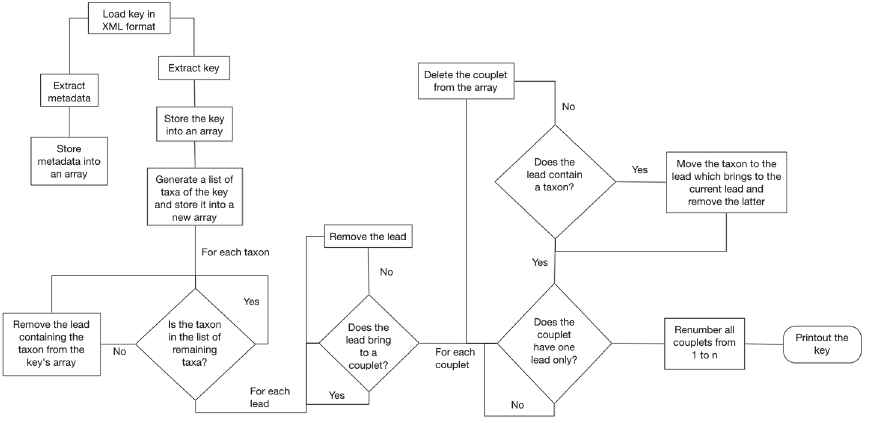
Fig 3. Reducing a key. The key array is compared with the list of remaining taxa by using the IDs, maintaining in the key array the useful leads only, and building a new, smaller dichotomous